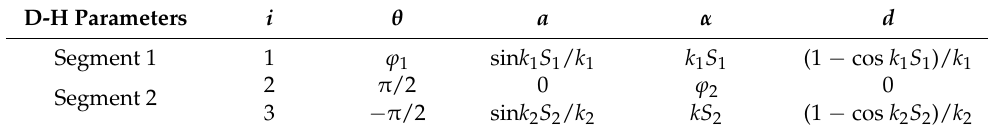
Table 3. CTR’s D-H